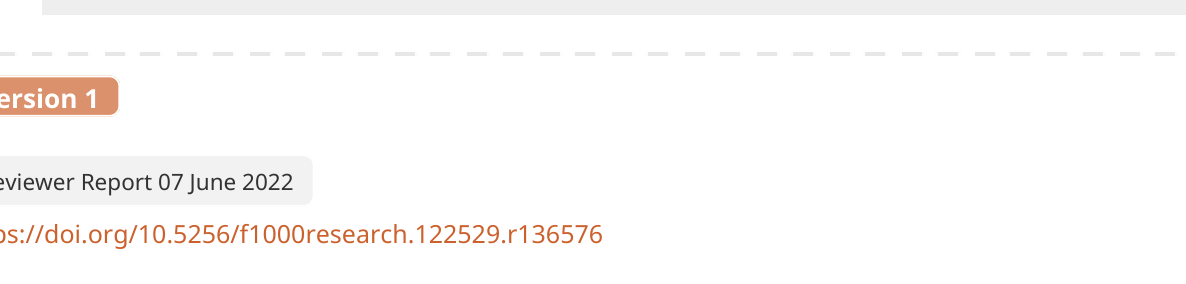
“Object <- Schema”. A variable “Object” is assigned a value of “Schema”1. “Object <- Object.properties.keyword”. Again a variable called “Object” is assigned a value located in “Object.properties.keyword”. Since this assignment happens in a loop, the “Object” variable is repeatedly overwritten with a new value obtained as the value of the “Keyword” variable